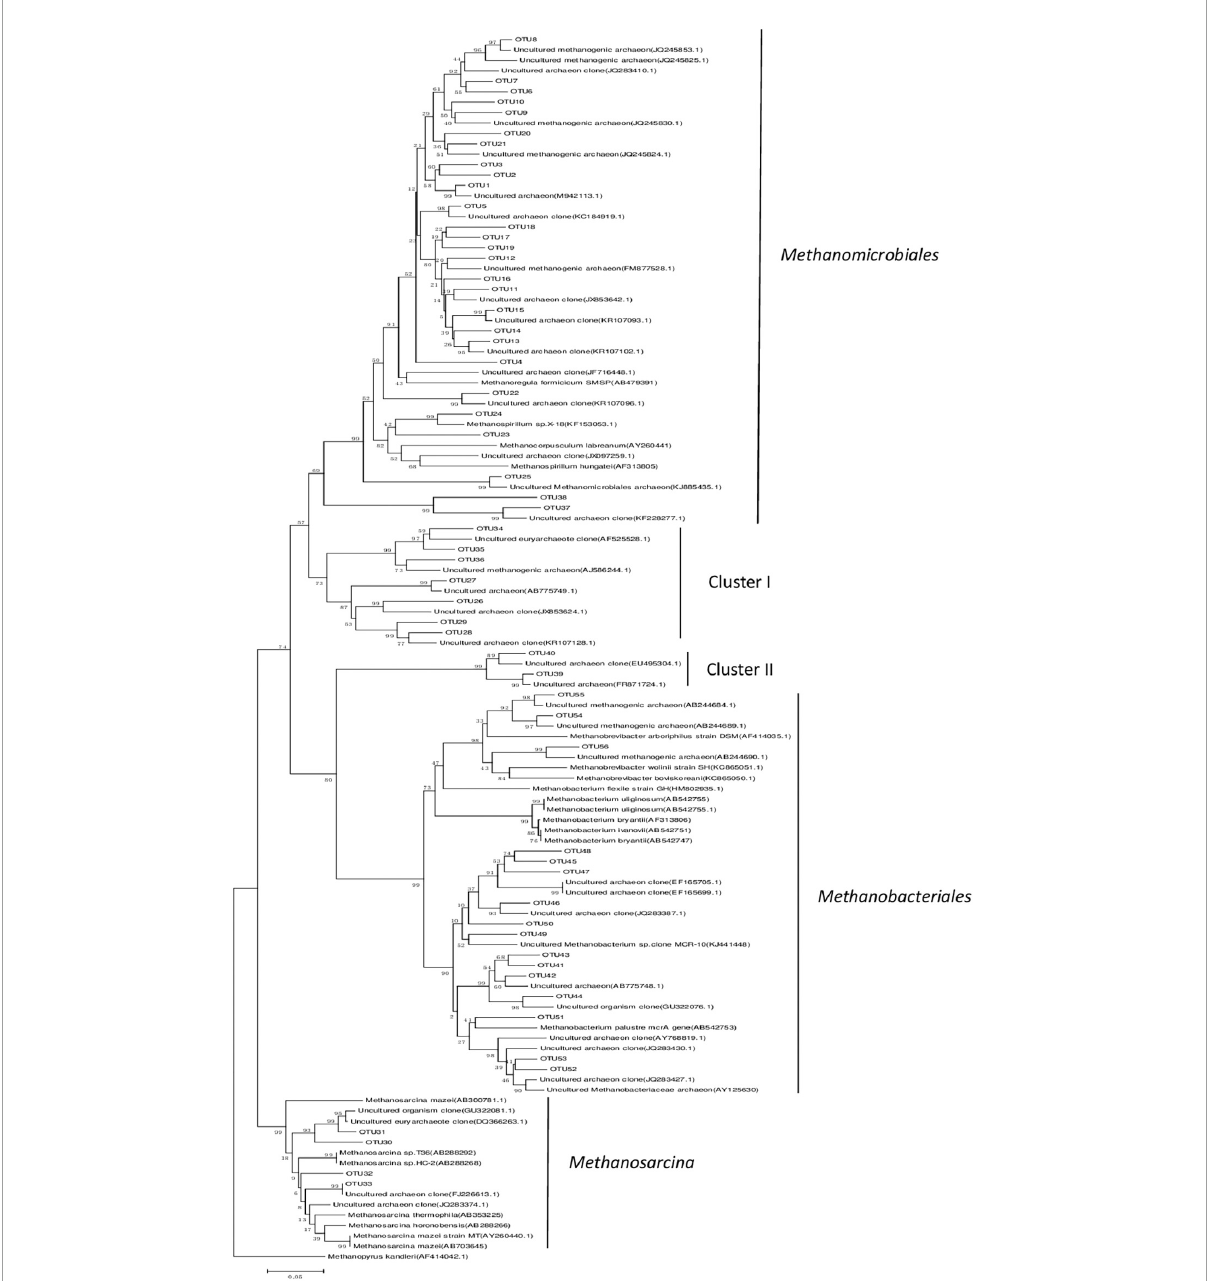
FIGURE2 Phylogenetic tree based on the mcr A gene clone sequences. Sequences obtained from peatland libraries are designated as OTUs. The tree was constructed using P -distance matrix analysis. GenBank accession numbers are indicated for all sequences. Methanopyrus kandleri was used as an outgroup. The scale bar indicates a 5% sequence